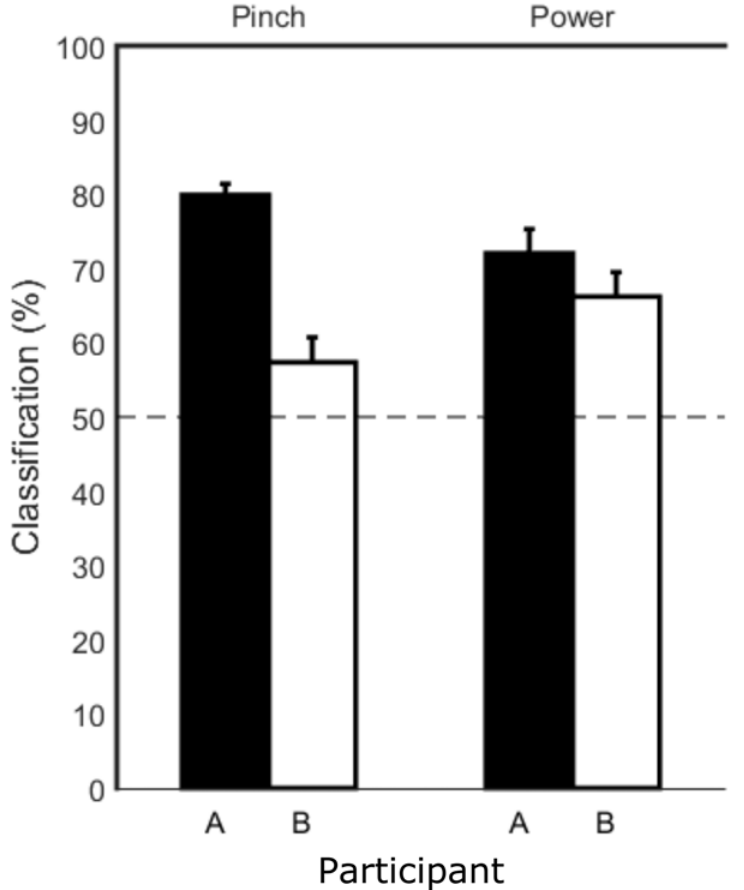
Fig 7. Average classification of imagined force versus rest. Bars show the average classification performance across 10 sets of cross-validation. The dotted horizontal line shows prior probability level (50%). The SVM was able to achieve significant classification of imagined force versus rest for both participants (A = black, B = white bars) and in both grasp configurations (pinch and